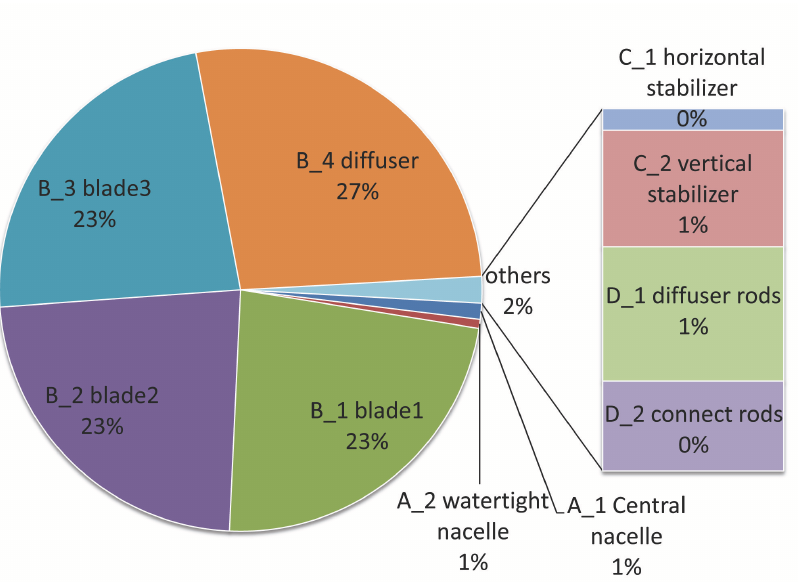
Figure 9. The axial force ratio for each turbine